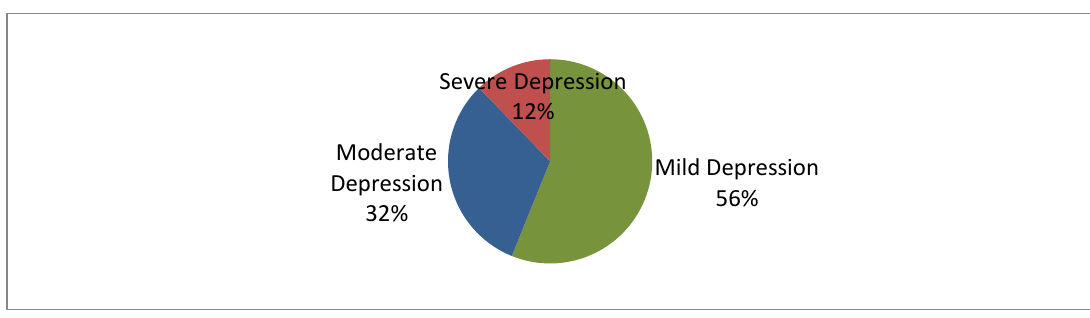
Figure (1) Distribution of the Depressed sample according to the severity of depression.